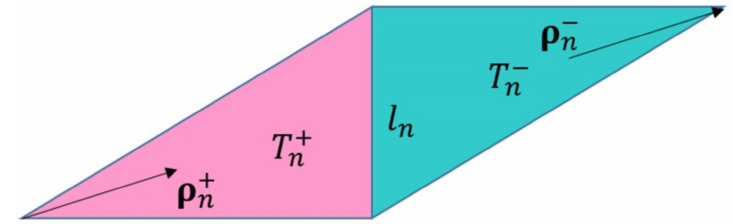
Figure 2. Planar RWG basis function diagram.